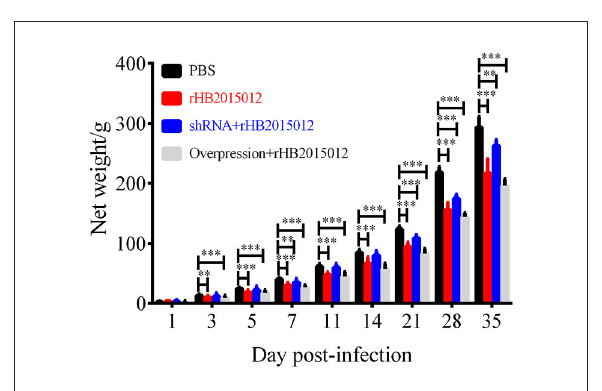
FIGURE4 Net gain in animal body weight. There was a net increase in the weight of animals in the four groups. PBS group had the largest weight gain, different from others. After A20 overexpression, ALV-A rHB2015012 group had the smallest body weight. Growth was suppressed in A20-disrupted group, although body weight was higher than in rHB2015012 group. * P < 0.05, ** P < 0.01, *** P <